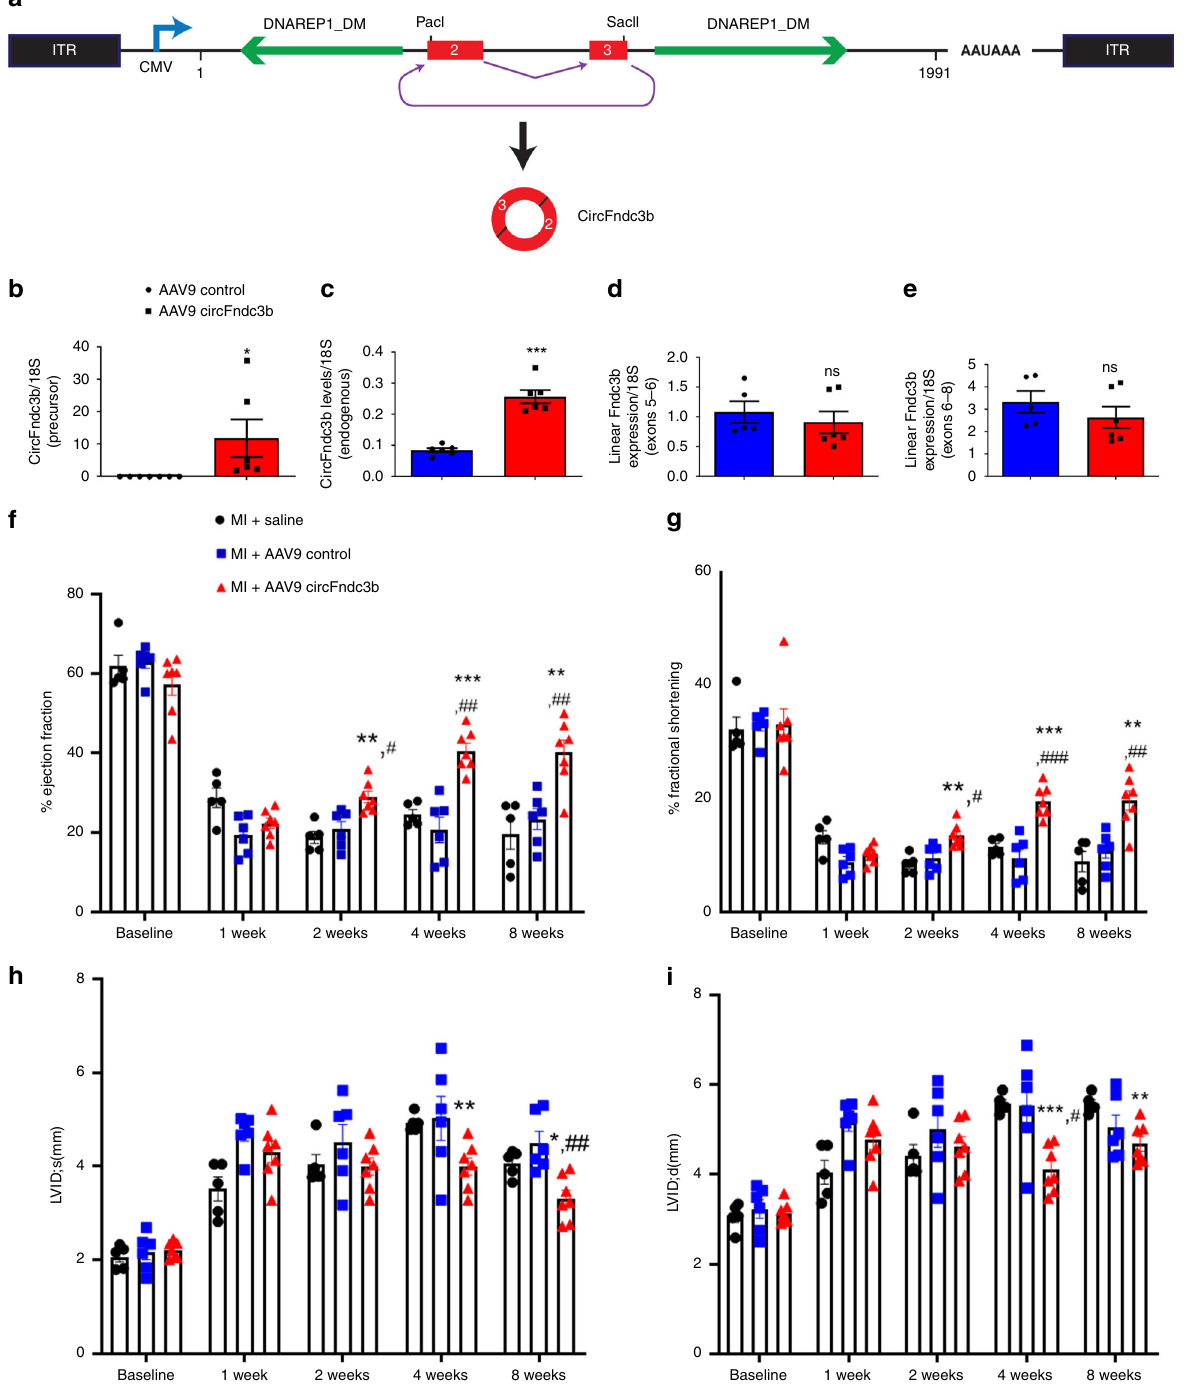
Fig. 4 AAV9 mediated overexpression of circFndc3b improves cardiac function 8 weeks after MI in mice: a AAV9 vector expressing circFndc3b. b , c RT- qPCR analysis of precursor-circFNDC3b ( n = 6 mice/group) and endogenous circFndc3b expression ( n = 6 mice/group) in AAV9 circFndc3b or AAV9 control treated hearts at 8 weeks post MI. n = 5 – 7/group. * p < 0.05, *** p < 0.001 vs AAV9 control (two-sided unpaired students t-test); c , d RT-qPCR analysis of linear Fndc3b mRNA expression in AAV9 circFndc3b ( n = 5 mice/group) or AAV9 control treated hearts ( n = 6 mice/group) at 8 weeks post MI. Not signi fi cant (ns) vs AAV9 control (two-sided unpaired students t -test); f – i AAV9 mediated overexpression of circFndc3b (n = 7 mice) improved LV function (% ejection fraction, % fractional shortening, LVID; s and LVID; d measured by echocardiography compared to AAV9 control ( n = 6 mice) or saline treatment groups (n = 5 mice). Data are Mean ± SEM. * p < 0.05, ** p < 0.01, *** p < 0.001 vs AAV9 control treated hearts. # p < 0.05, ## p < 0.01, ###